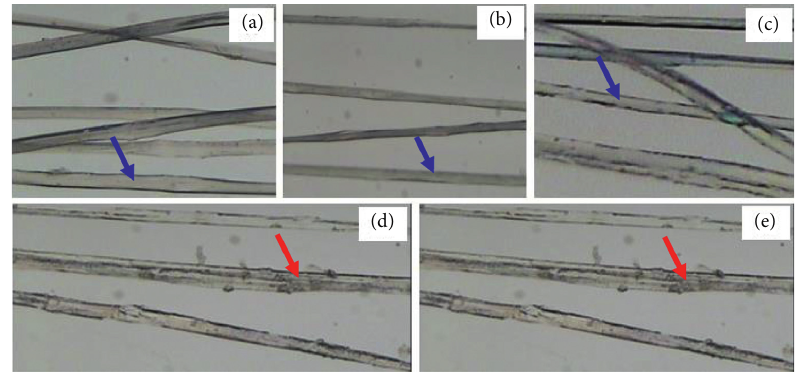
Figure 1: Microscopic structure of eri and mulberry silk fibres: (a) Awassa, (b) Addis Ababa, (c) Arba Minch, (d) bivoltine, and (e) multivoltine.